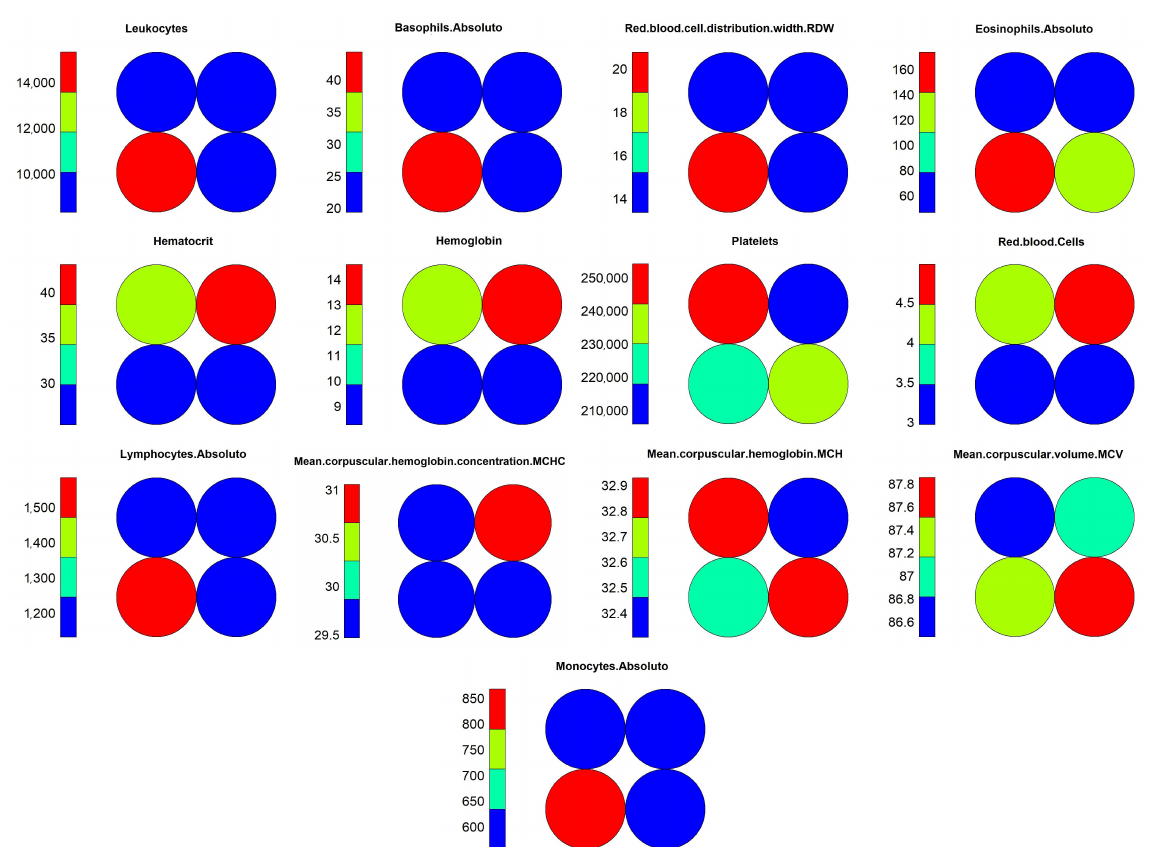
Figure 16. Heatmap of the variables per neuron level 1 TESSOM